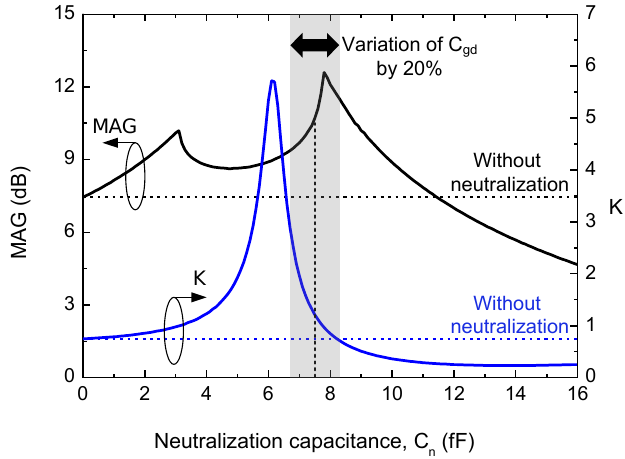
Figure 3. Improvement of the maximum available gain (MAG) and stability factor (K) at 79 GHz by a neutralization capacitor (C n ).